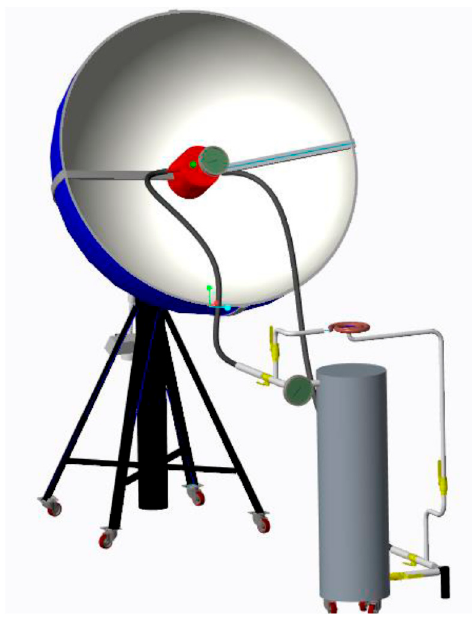
Figure 6. CAD /CAM Model of the solar concentrator.